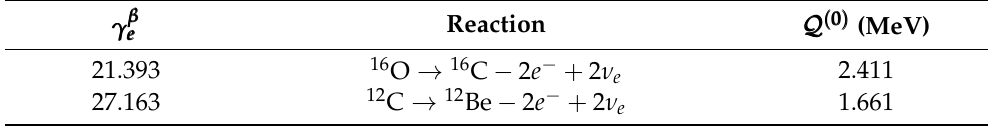
Table 6. Same as in Tables 4 but considering reactions involving carbon and